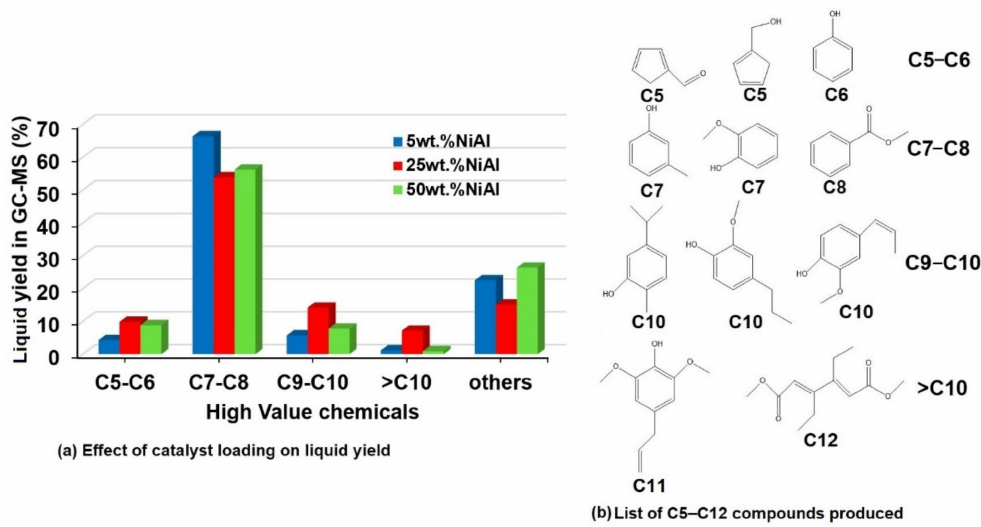
Figure 7. Effect of catalytic loading with respect to biomass on liquid yields at reaction conditions of 300 ◦ C, 6 h, 2 g biomass, 2 bar initial pressure, methanol as solvent, and biomass particle size of 180 µ